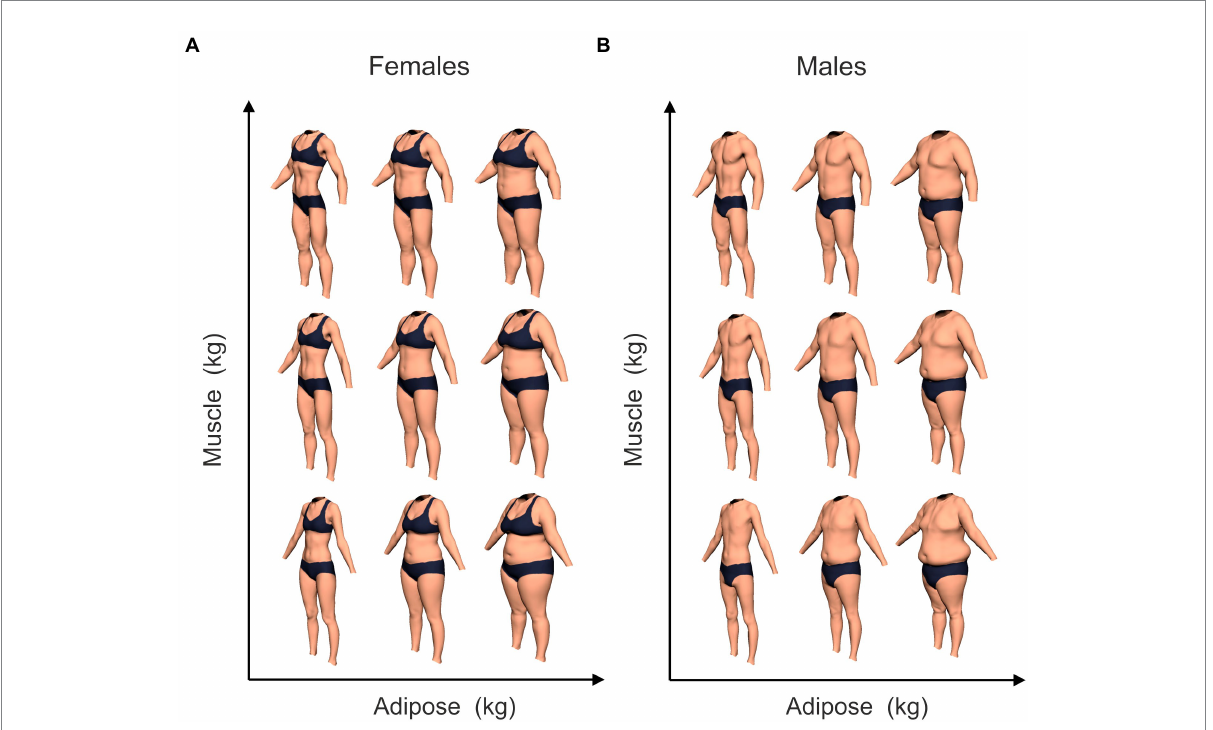
FIGURE 2 Examples of the CGI bodies used in this study to illustrate the changes of body shape and size of the female stimuli (A) and male stimuli (B) produced by changing their body composition based on our PCA of the 3D scanned bodies. The bodies in each set are grouped into three columns, from left to right: low, mid, and high muscle tone. They are further divided into three rows from bottom to top: low, mid, and high muscle